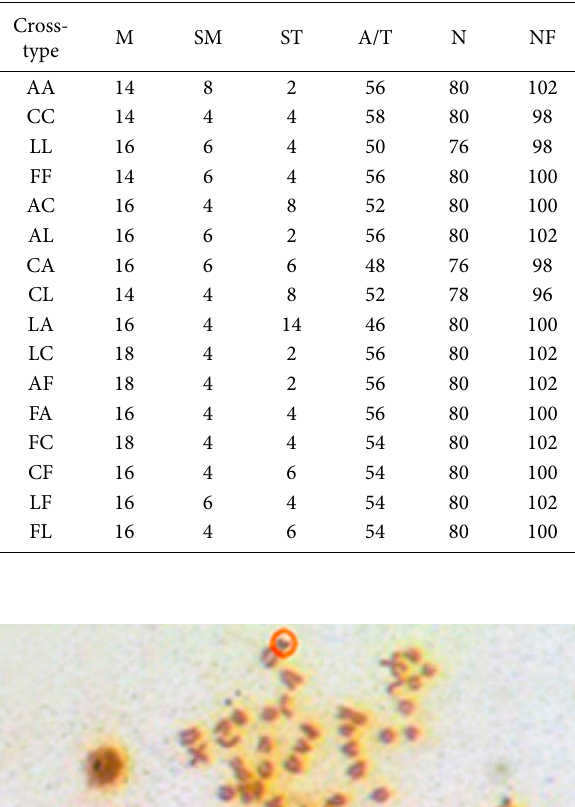
Table 3. Chromosome number (N) fundamental number (NF) and